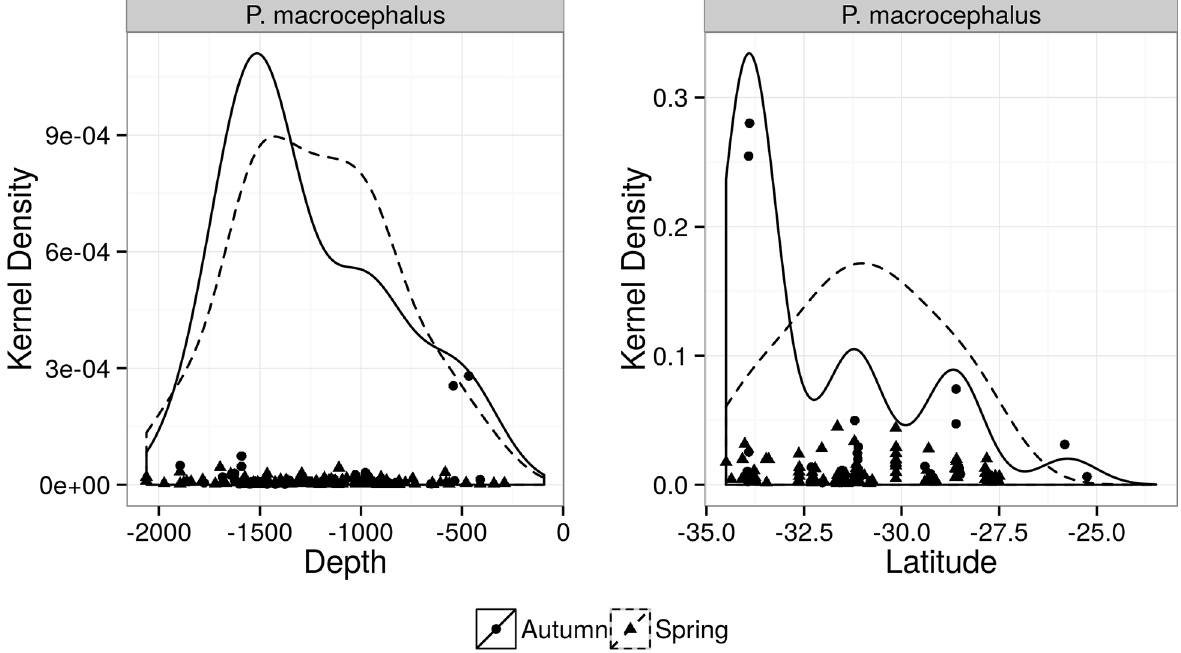
Fig 4. Kernel density of sperm whale ( Physeter macrocephalus ) distribution. Plots are according to depth (left) and latitude (right) during spring (dashed lines) and autumn (solid black lines)